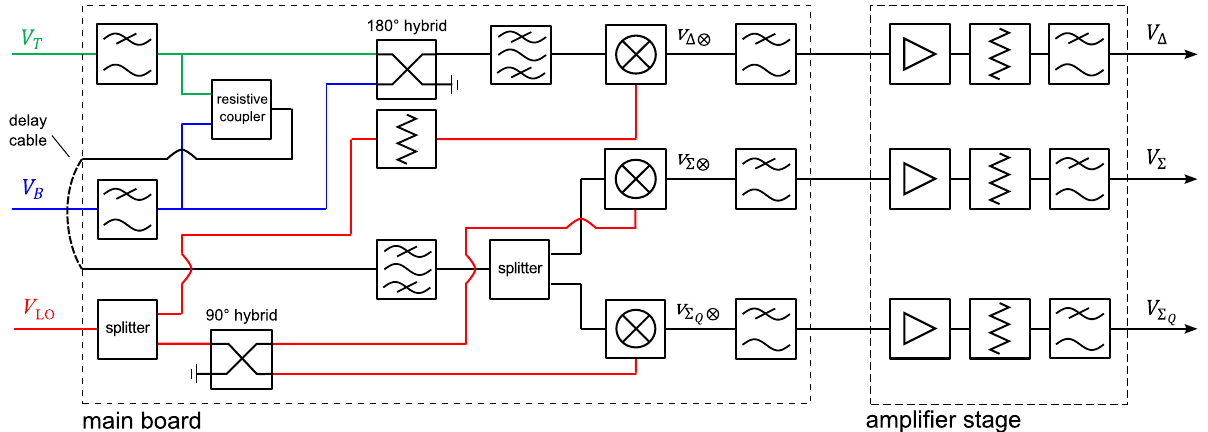
FIG. 7. Schematic diagram illustrating the structure of the FONT5 analogue